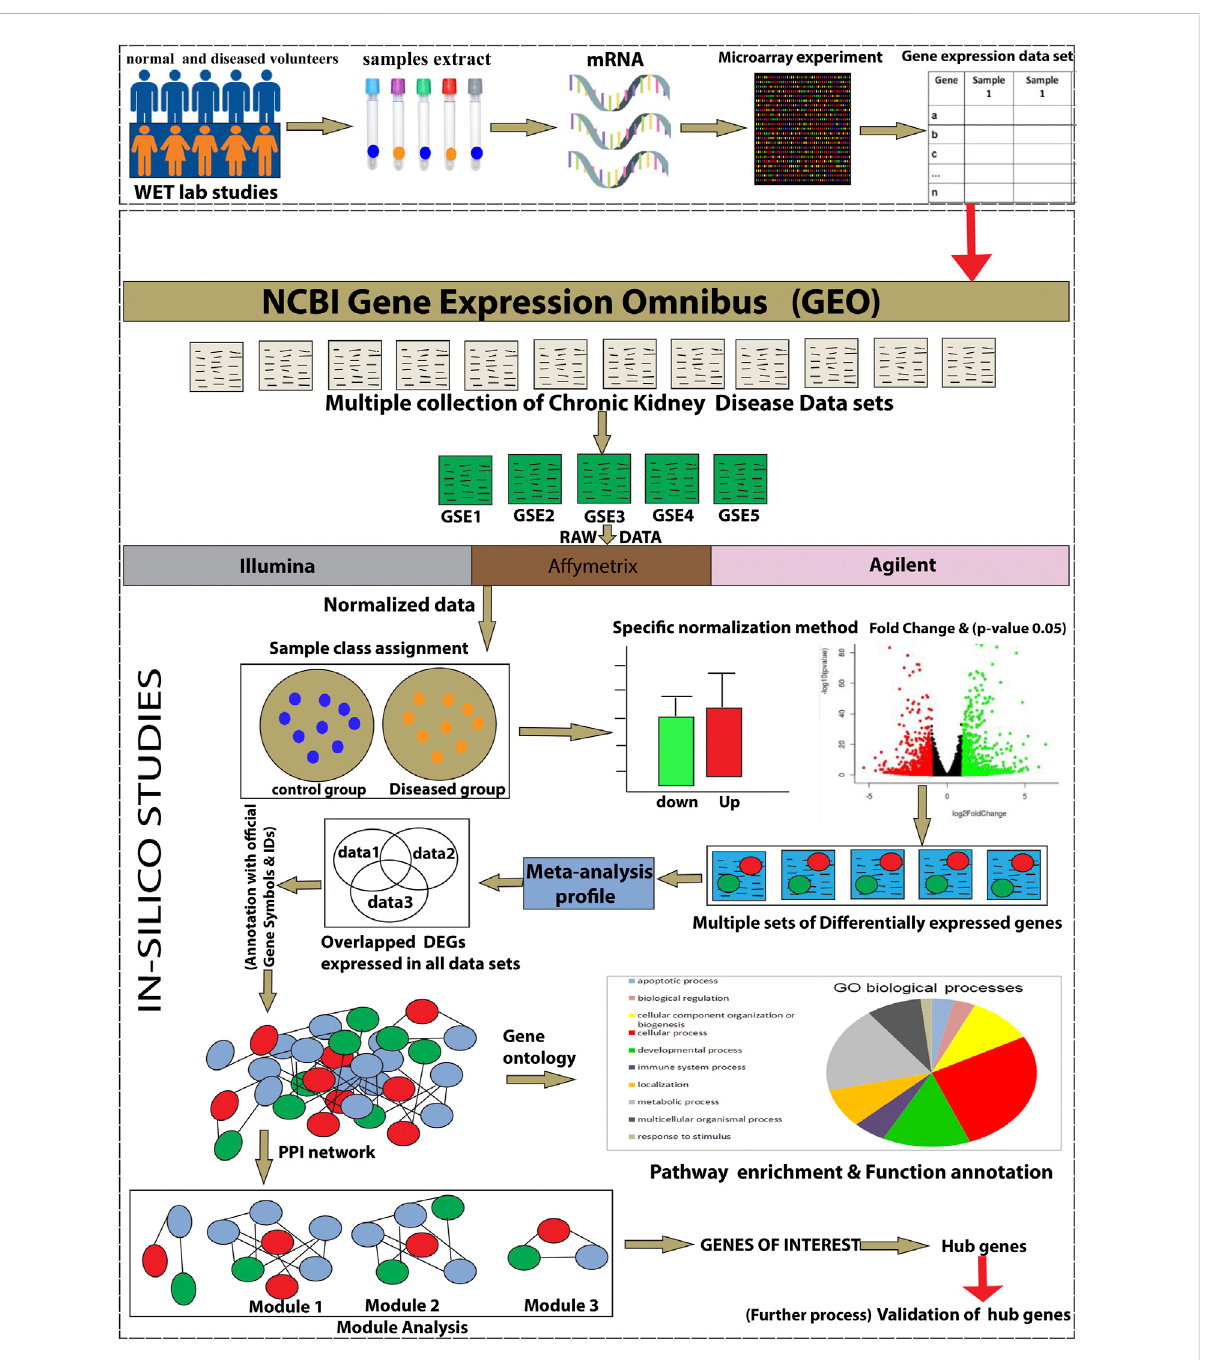
FIGURE 1 The schematic representation of the present study work fl ow through an integrative network-based